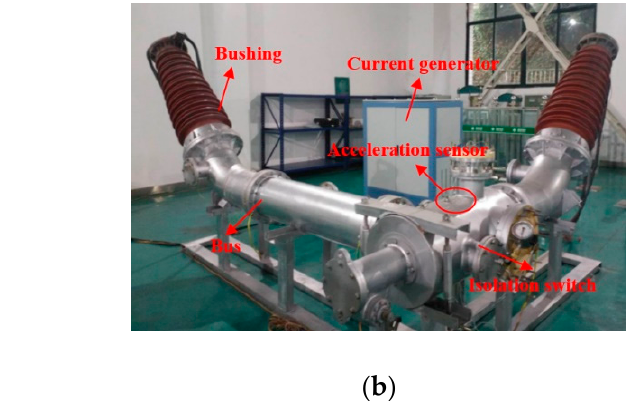
Figure 8. GIS vibration experiment system. ( a ) Experimental setup. ( b ) Physical object of test platform.